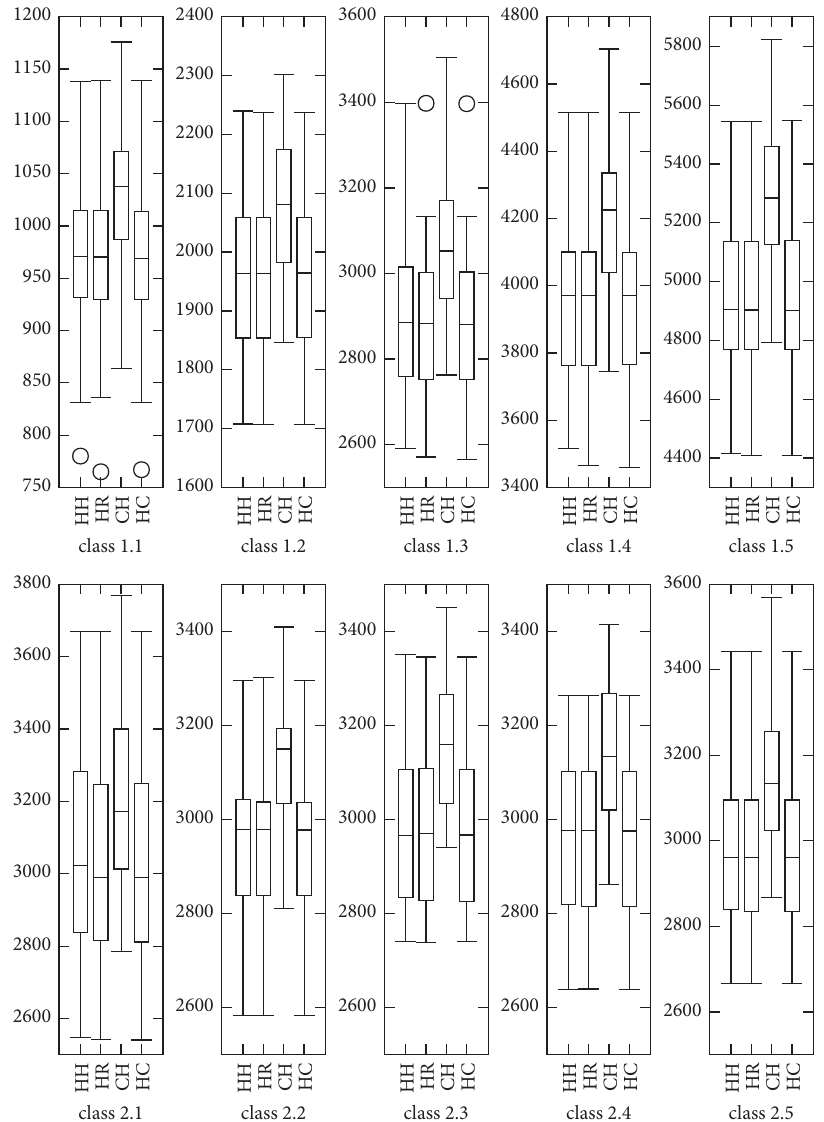
Figure 9: Boxplots of lengths of schedules (minimum, lower quartile, median, upper quartile, maximum, and outliers) returned by the LS algorithms for the benchmark given in [9] with cov �